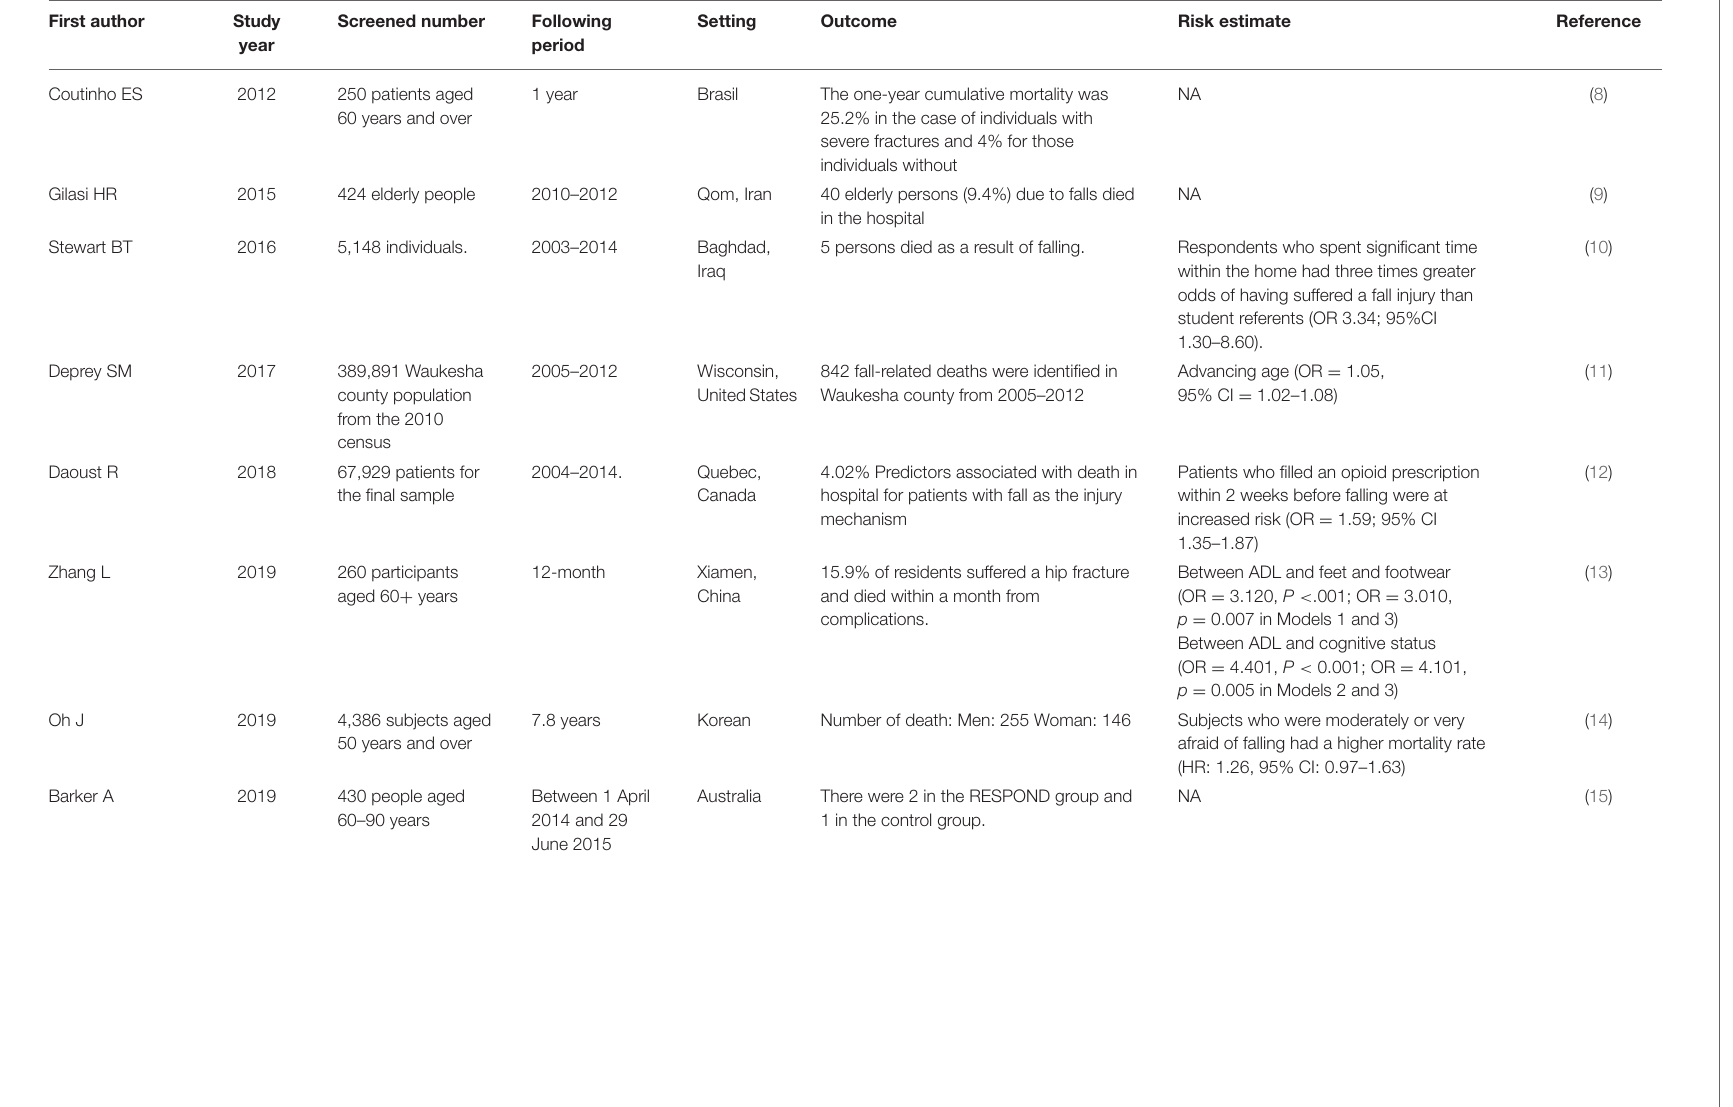
TABLE 5 | The outcome evaluation of fall in older adults’ residences in various